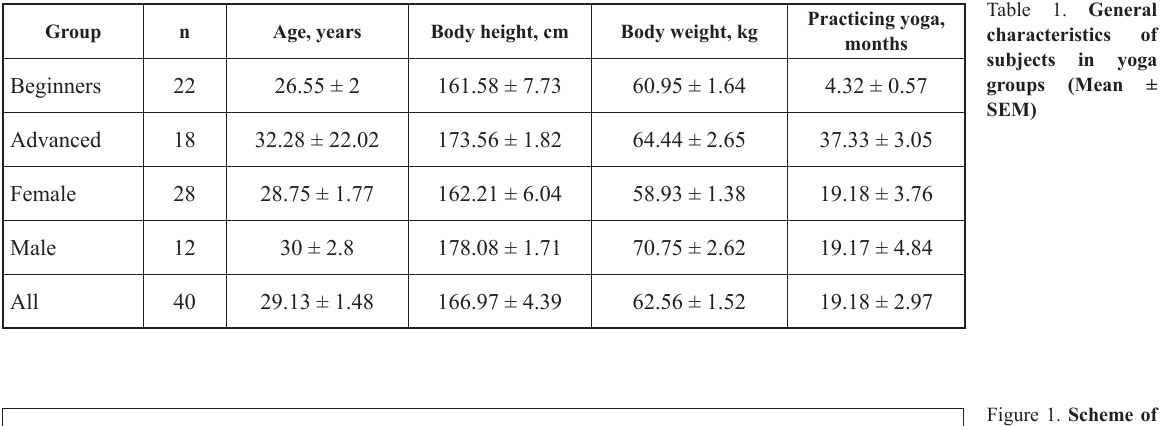
Figure 1. Scheme of the